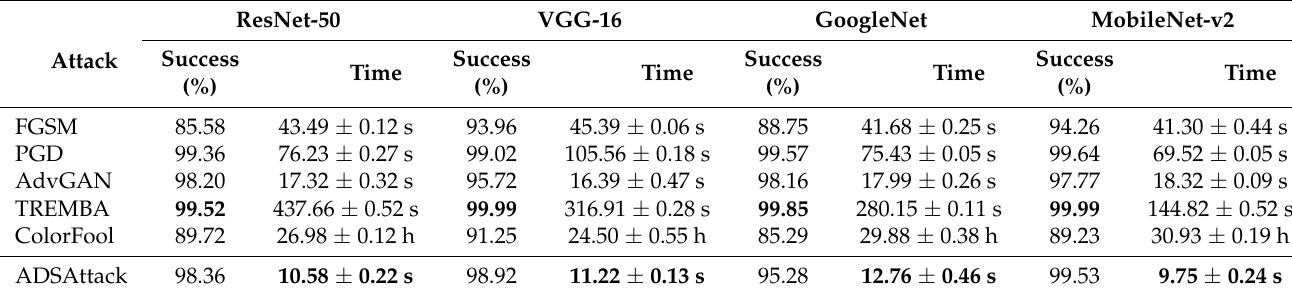
Table 1. Comparison experiments of six algorithms, including FGSM, PGD, AdvGAN, TREMBA, ColorFool and our ADSAttack. There are two performance metrics that include the attack success rate (%) and the time to batch (1000) generation ( ± std over 5 random runs).